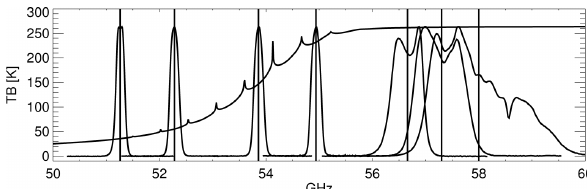
Figure 10. The oxygen absorption complex at V-band notice individual absorption peaks that 5 Fig. 10. The oxygen absorption complex at V-band notice individual are resolved. Also plotted are the HATPRO radiometer V-band channels and their respective 6 absorption peaks that are resolved. Also plotted are the HATPRO ra- bandwidths. The TB spectrum plotted here was made using a sounding from RHUBIC-II in 7 diometer V-band channels and their respective bandwidths. The TB Chile (5322m ABSL). (G. Maschwitz, personal communication, June 2012) 8 spectrum plotted here was made using a sounding from RHUBIC-II in Chile (5322m above m.s.l.) (G. Maschwitz, personal communi- cation, June